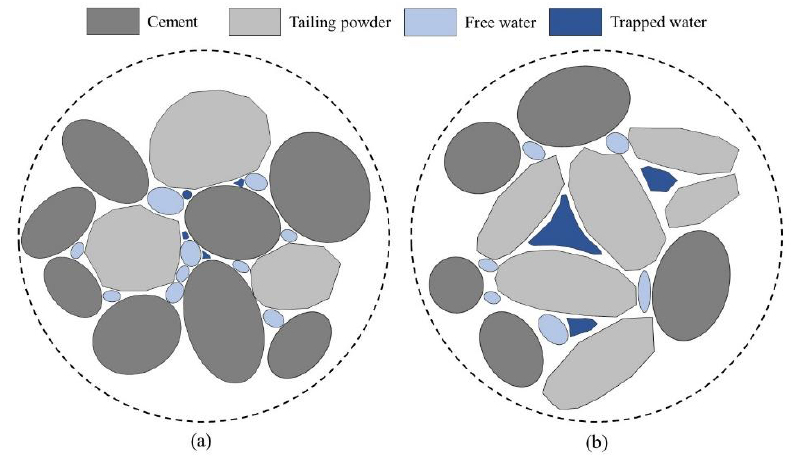
Figure 10. Schematic diagram of particle packing structure. ( a ) RAWTP or 1.0HTP; ( b ) 0.5HTP.